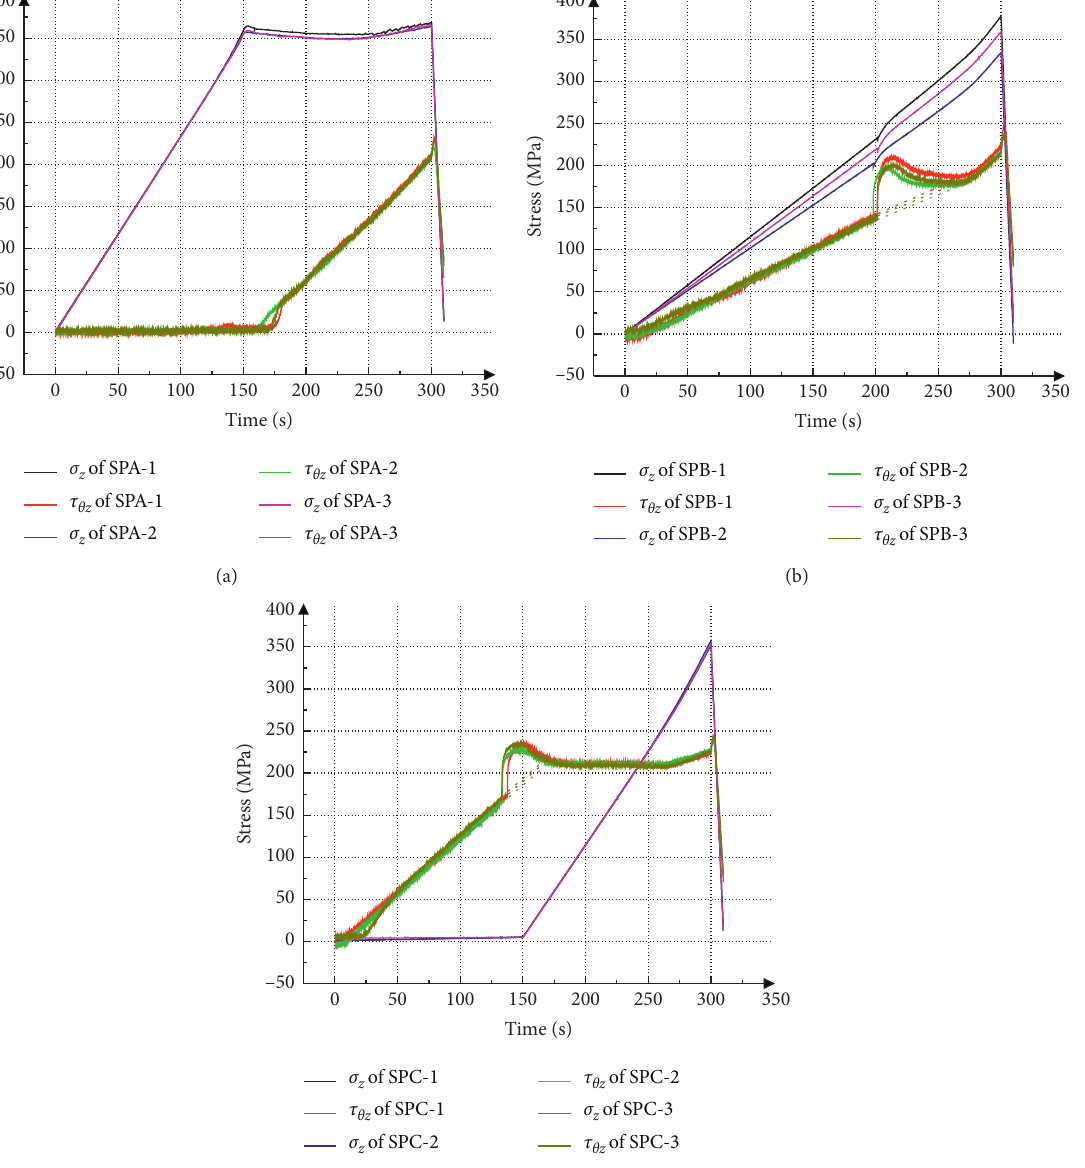
Figure 16: Stress-time curves of stress paths A (a), B (b), and C